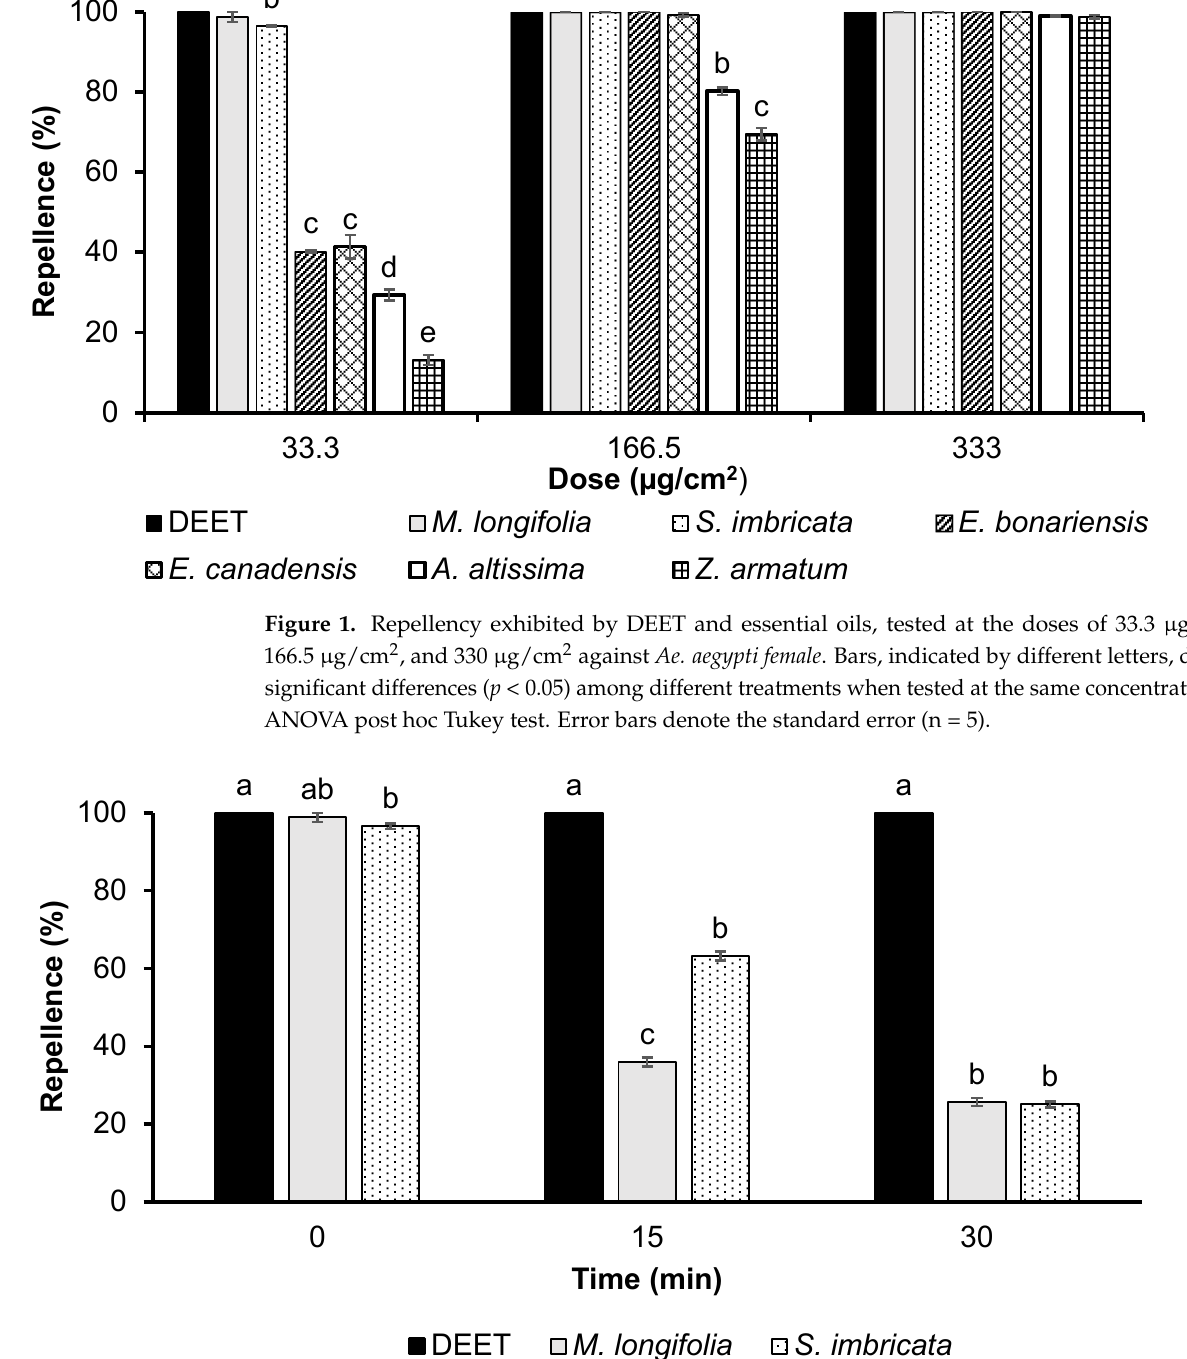
Figure 3. Time-based repellency of DEET and essential oils at a dose of 166.5 μ g/cm 2 against Ae. aegypti . Bars having different letters depict significant differences ( p < 0.05) among the repellency of different tested substances at different periods of post-treatment that were compared for each pe- riod independently by ANOVA post hoc Tukey test. Error bars denote the standard error (n = 5). 3.2.3. Time Span Repellency at a Dose of 330 μ g/cm 2 GLM analyses showed significant effects of EO type ( df = 6, F = 2803, p < 0.001) and time ( df = 5, F = 11813, p < 0.001) on the repellency effect. All the tested plants showed